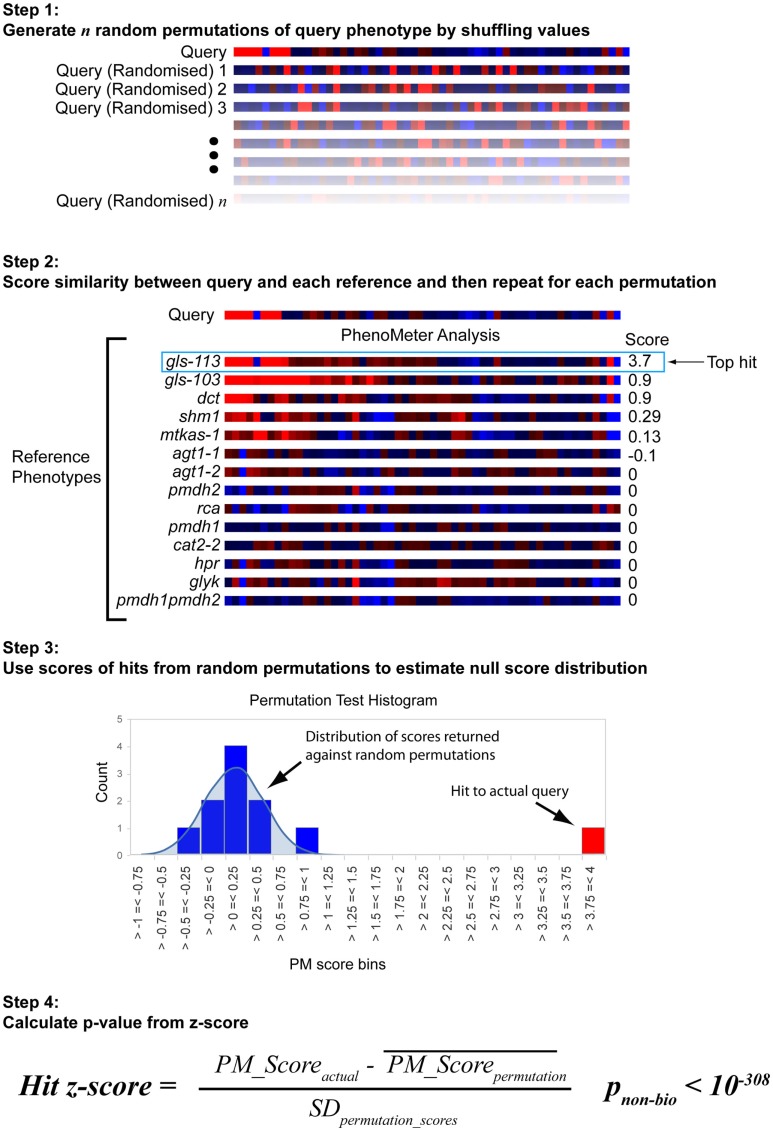
Estimation of statistical significance via permutation testing. The probability of obtaining a given PhenoMeter score by chance is dependent upon algorithm settings and the nature of the bait and reference phenotype search space. To estimate the chance of obtaining the reported score by chance, each bait search is therefore accompanied by a permutation test in which random permutations of the bait phenotype are searched in an otherwise identical manner. The mean and standard deviation (SD) of the scores from these searches is then used to calculate a z-score for the actual score from which a p-value is estimated. We call this p-value pnon-bio because it represents the probability of the match score not having arisen out of biology.